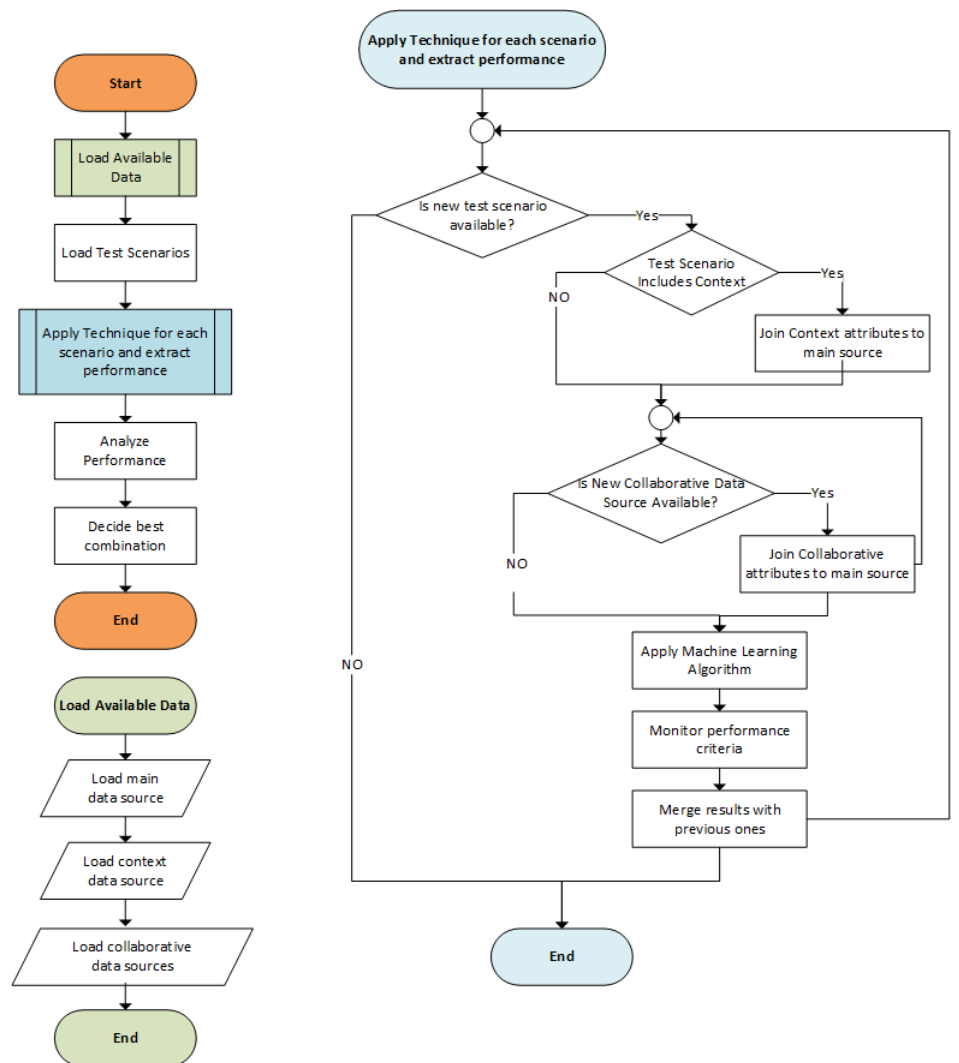
Figure 2. Scenarios Platform-Collaborative & Context-Aware Data Mining (SP-CCADM) flow